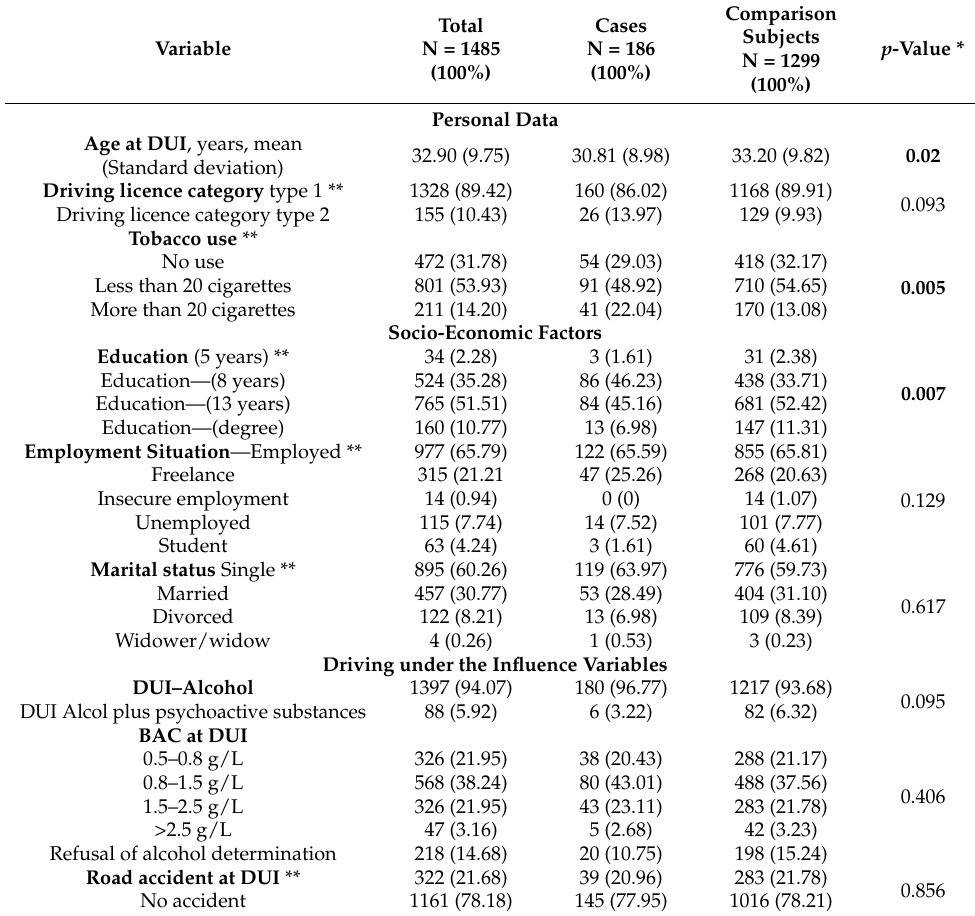
Table 3. Personal data, socio-economic factors, and conditions at DUI in male recidivists and comparison